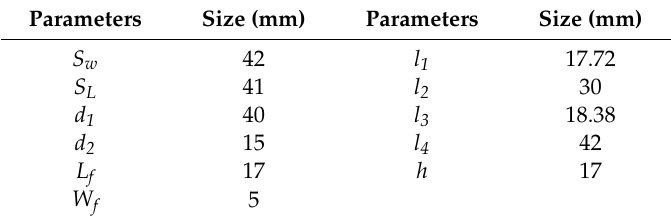
Figure 2. Fabricated prototype: ( a ) Front view; ( b ) Rear view. Table 1. All optimized parameters of the proposed prototype.